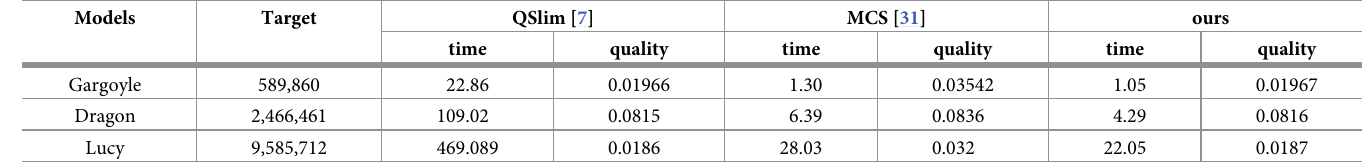
Table 2. The time expended in seconds and the quality measures of the simplification of the input meshes in comparison with those of QSlim [7] and MCS [31]. Models